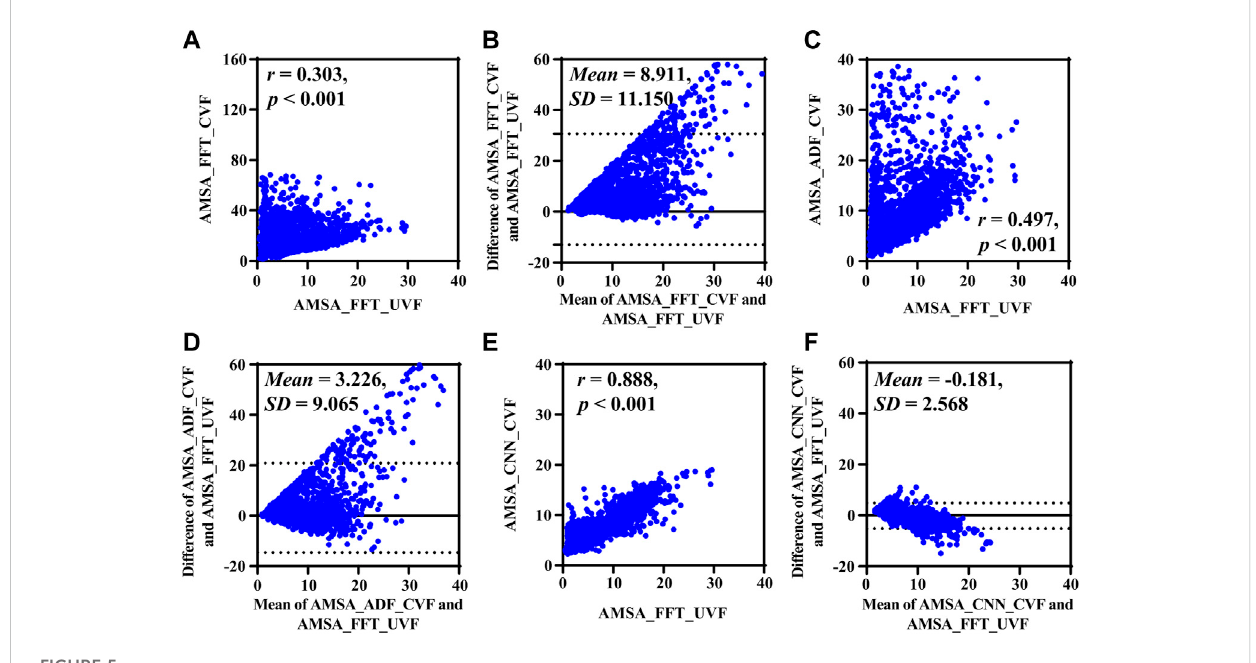
FIGURE 5 Performance results on real-life data. (A) Relationship and (B) difference between AMSA_FFT of corrupted and adjacent uncorrupted VFs. (C) Relationship and (D) difference between AMSA_ADF of the corrupted VF and AMSA_FFT of the adjacent uncorrupted VF. (E) Relationship and (F) difference between the AMSA_CNN of the corrupted VF and AMSA_FFT of the adjacent uncorrupted VF.